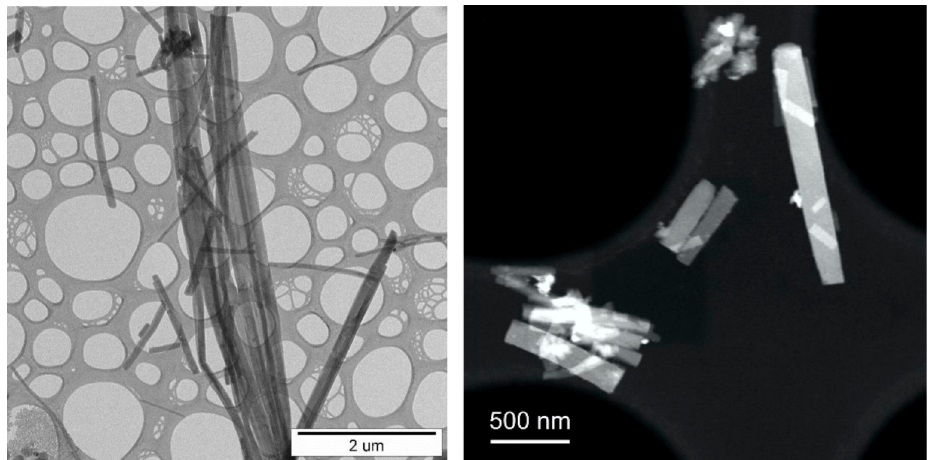
Figure 17. Transmission electron micrographs of ICR-2 ( left ) (Reprinted with permission from reference. [82]. Copyright 2018, Wiley-VCH Verlag GmbH and Co.) and CAU-30 ( right ) (Reprinted with permission from reference. [47]. Copyright 2018, Royal Society of Chemistry).